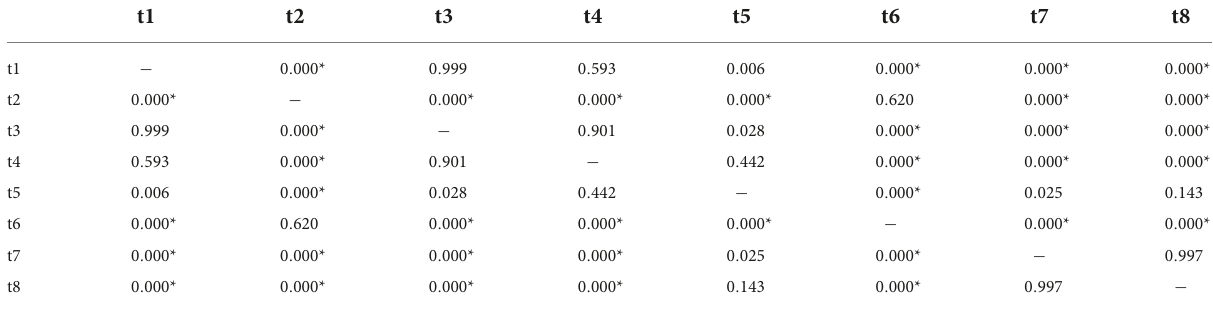
TABLE 12 Pairwise comparison of the treatments for SOD by Scheffe post hoc test.